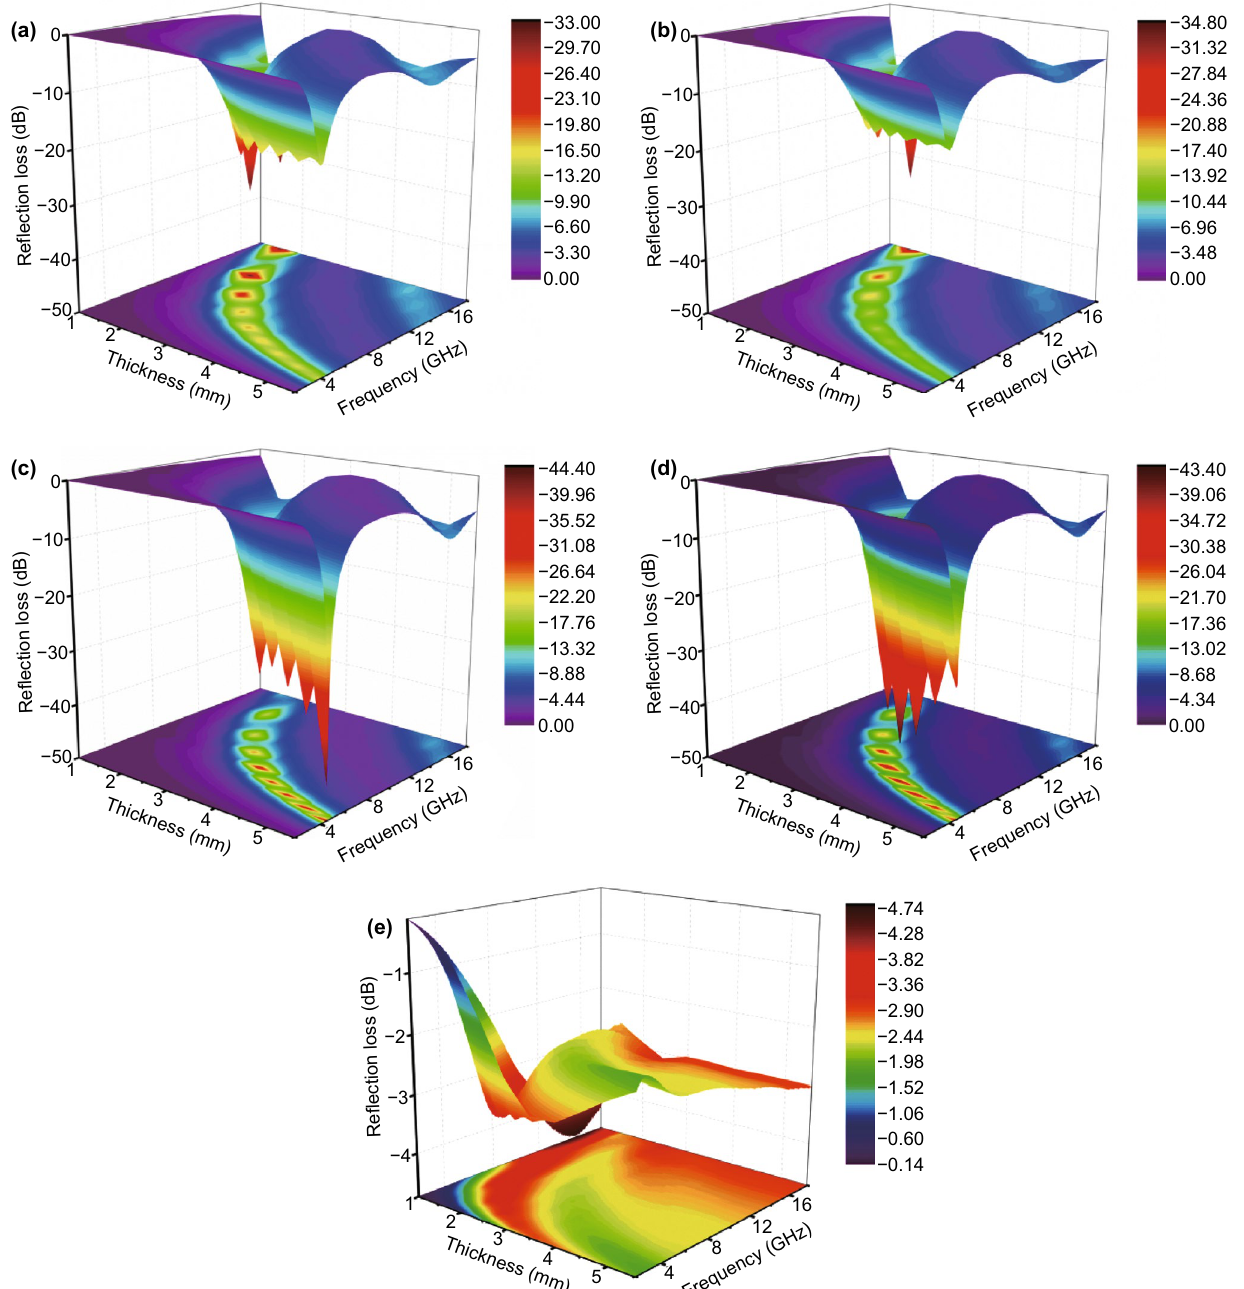
Fig. 8 Three-dimensional reflection loss maps of a FMCA-1, b FMCA-2, c FMCA-3, d FMCA-4, and e Fe@C over 2–18